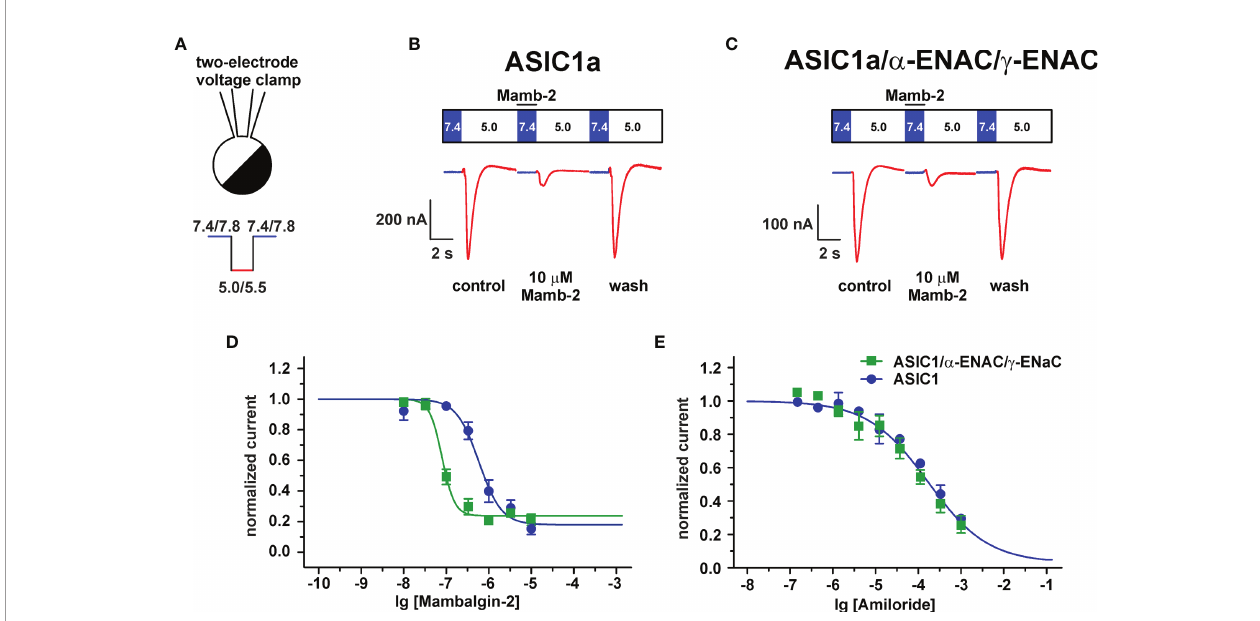
FIGURE 7 | Analysis of mambalgin-2 and amiloride action at ASIC1a and ASIC1a/ a -ENaC/ g -ENaC channels in Xenopus laevis oocytes. (A) Two-electrode con fi guration of the patch-clamp technique and protocol of experiments. Representative current traces recorded in X. laevis oocytes expressing the hASIC1a (B) and hASIC1a/ a -ENAC/ g -ENAC (C) channels; traces for non-injected oocytes were used as control and are shown in Figure S9 . The pre-incubation with mambalgin-2 was 15 s (shown off time scale), the stimulation phase (pH 5.0) was 7 s, and the recovery phase is not shown. (D) Dose – response curves for mambalgin-2 inhibitory effect. For each mambalgin-2 concentration, the current response was normalized to the control experiment. Each data point represents an average from independent experiments in different oocytes ± SEM (n =11 for both channels). The fi tted curves are described by single-component Hill ’ s equation. (E) Dose – response curves for amiloride inhibitory effect. The data points are shown as normalized average ± SEM (n = 3 for both